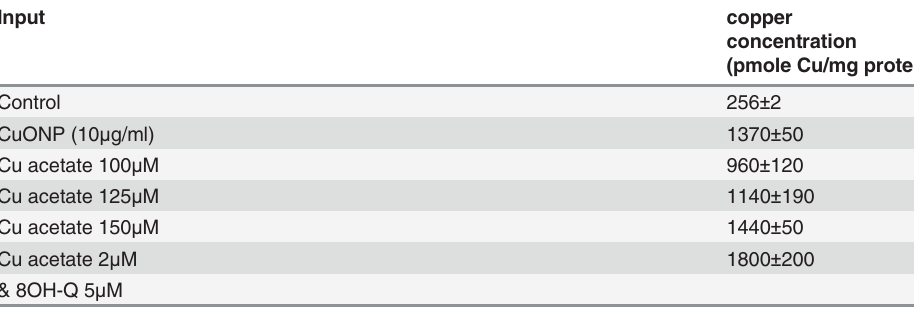
Table 2. Copper dissolution in